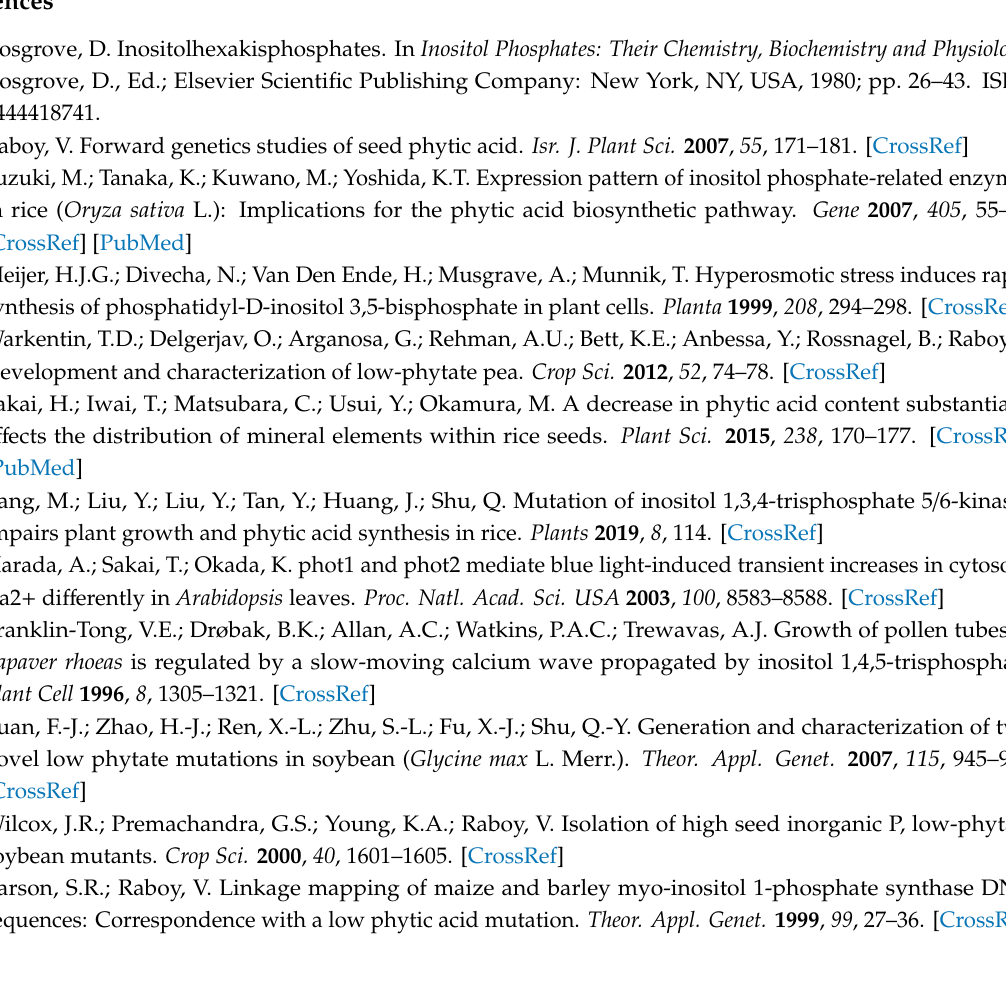
Figure S1. Secondary structure of Protospacer-sgRNA. Figure S2. Characterization of target genomic sequence in HvITPK1 . Figure S3. Digestion of expression vector by Mlu I. Figure S4. Verification of qRT-PCR primers specificity. Figure S5. Calibration curves for internal control and HvITPK genes used in qRT-PCR. Table S1. List of primers used for genotyping and qRT-PCR. File S1. Genotyping of T0